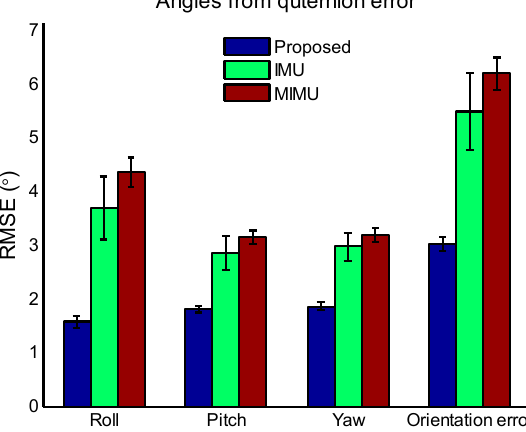
Figure 12. The mean and standard deviation of RMSEs of Euler angles and orientation error of all the ten trials. The bars represent the 95% confidence intervals.